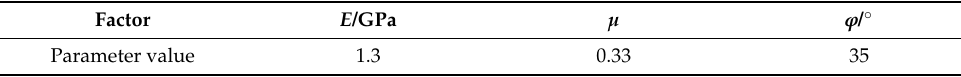
Table 7. Inversion results of surrounding rock parameters.